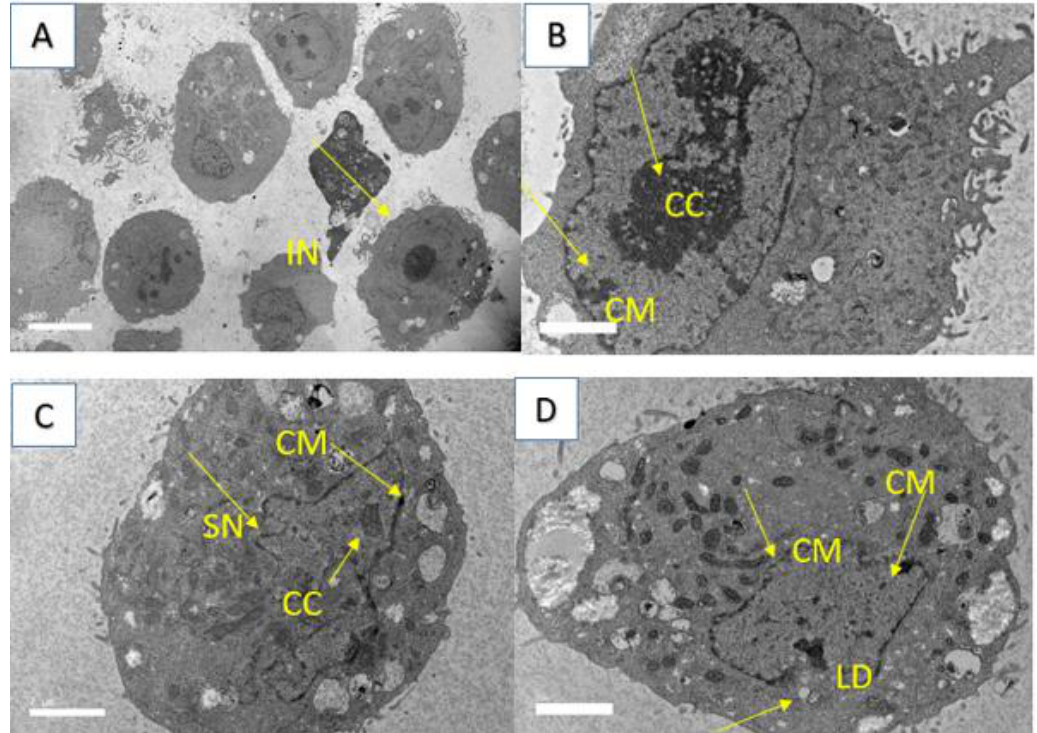
Figure 12. TEM for MCF-7 cell line. ( A ) control, ( B ) treated cells 24 h, ( C ) 48 h and ( D ) 72 h, respec- tively. IN, Intact nucleus; CC, chromatin condensation; CM, chromatin margination; SN, shrinkage of nuclei; LD, lipid droplet.